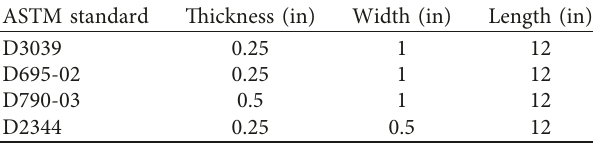
Table 1: Specimen dimensions for composite characterization. ASTM